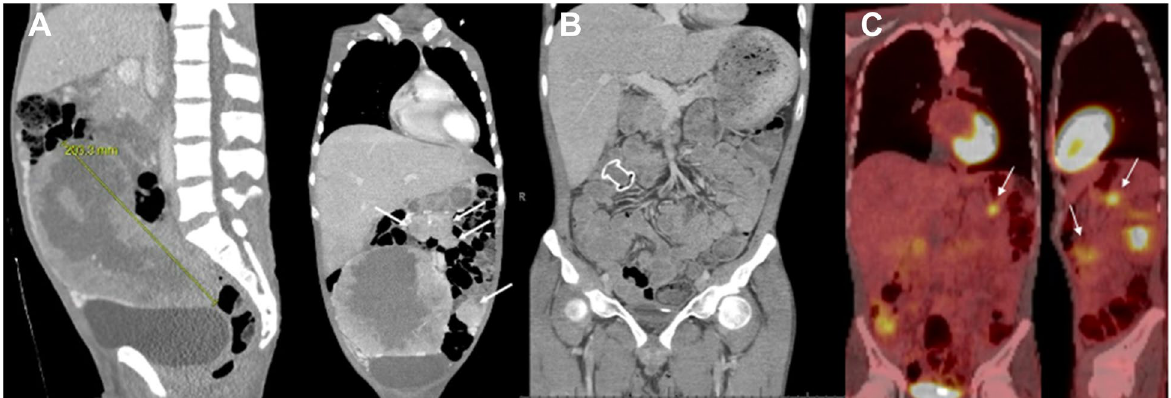
Fig. 2 Radiographic image findings. A Sagittal and coronal CT abdominal images on initial presentation showing a large abdominopelvic mass. White arrows in coronal view highlight metastatic disease in the abdomen. B Coronal CT abdominal post-surgical interventions showing absence of the main mass and the LAMS stent. C Coronal and sagittal PET CT images one month post initiation of nab-sirolimus showing stable residual disease in the abdomen as highlighted by the white